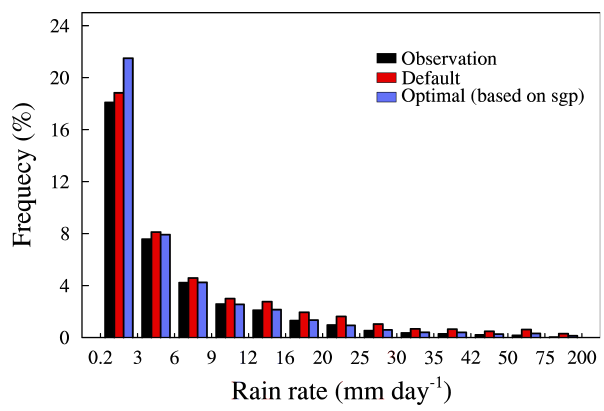
Fig. 14. The observed and simulated (25-km) frequency distribu- tions of daily precipitation over NAM for July 1991 as a function of rain rates, with default and optimized (based on EC in SGP) param- eters in the KF